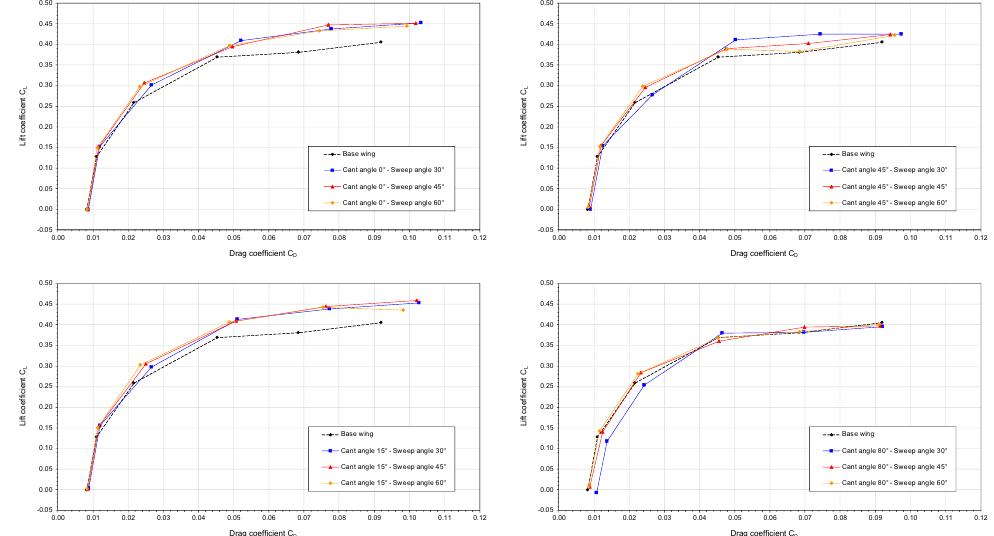
Figure 14. Drag polar at Mach number 0.8395. Each image corresponds to a fix cant angle and three different values of sweep